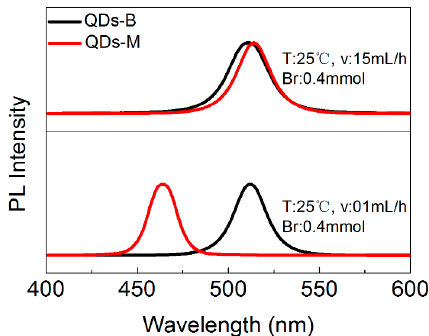
Figure A7. Comparison graph of QDs-M’s and QDs-B’s emission spectrum with toluene as nonpolar